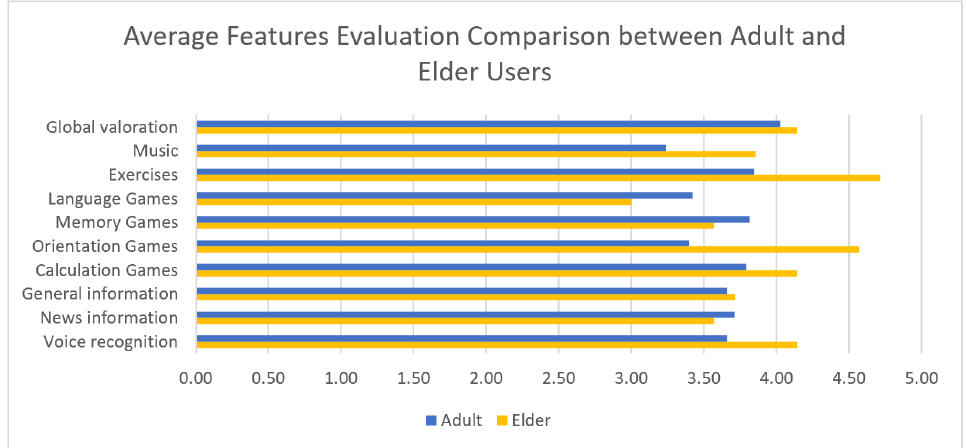
Figure 10. Average Features Evaluation Comparison between Adult and Elderly